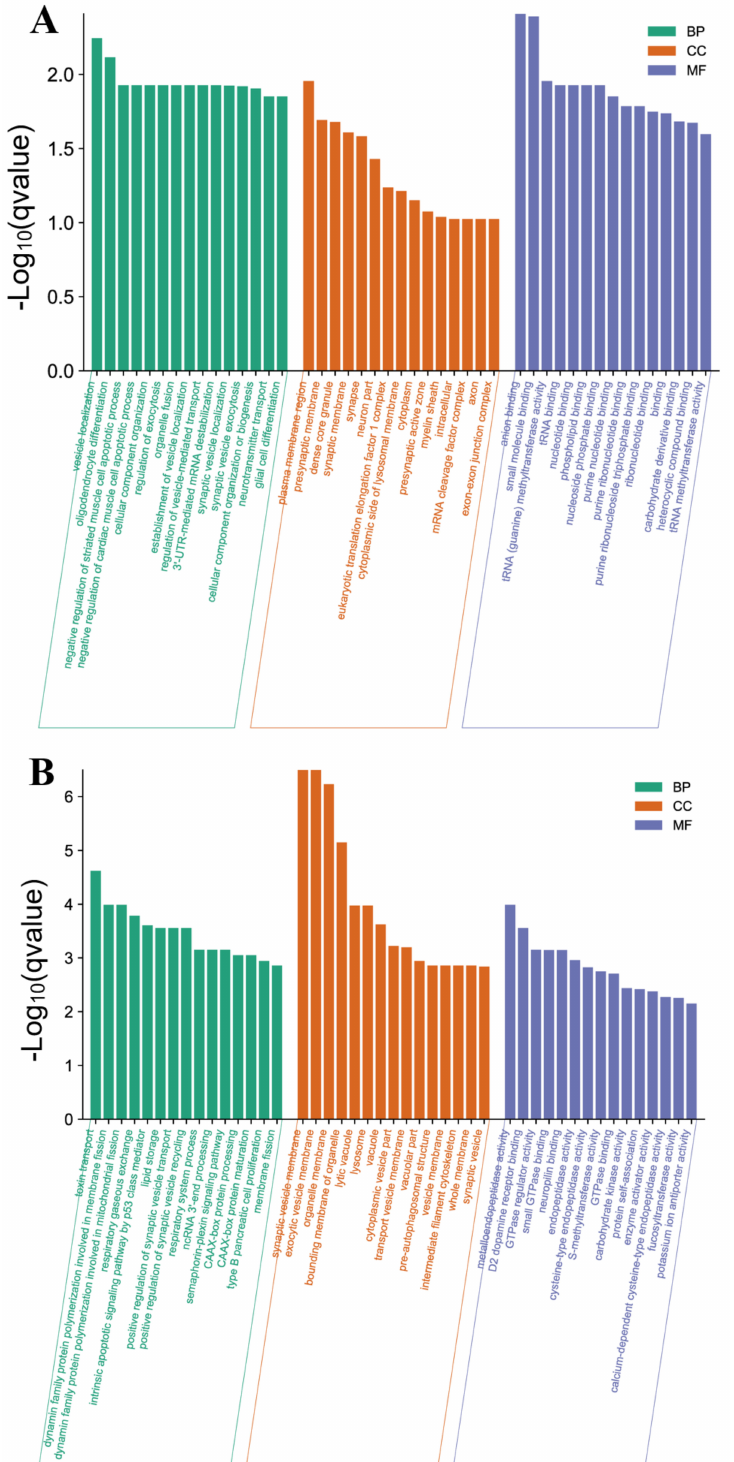
Figure 5. The top 15 enriched GO terms for the identified DEGs and the target genes of the DEMs in the LP-HF vs LP-LF. The q -value < 0.05 was used as a threshold to select significant GO terms. The X-axis and Y-axis represent the GO terms and the -log 10 ( q value) of the enriched genes, respectively. GO; Gene ontology, BP; biology process, CC; cellular component, MF; molecular function. ( A ) GO enrichment terms for the DEGs in the LP-HF vs LP-LF. ( B ) GO enrichment terms for the target genes of the DEMs in the LP-HF vs